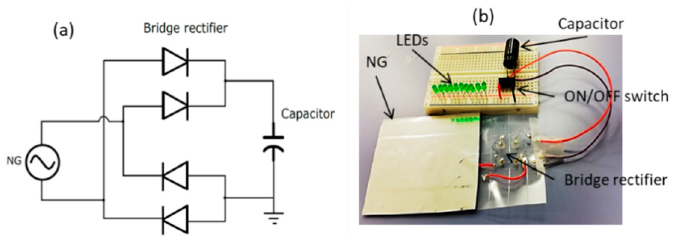
Figure 3. ( a ) Schematic diagram of the NG connected with bridge and storage capacitor. ( b ) Digital photograph of the fabricated system.